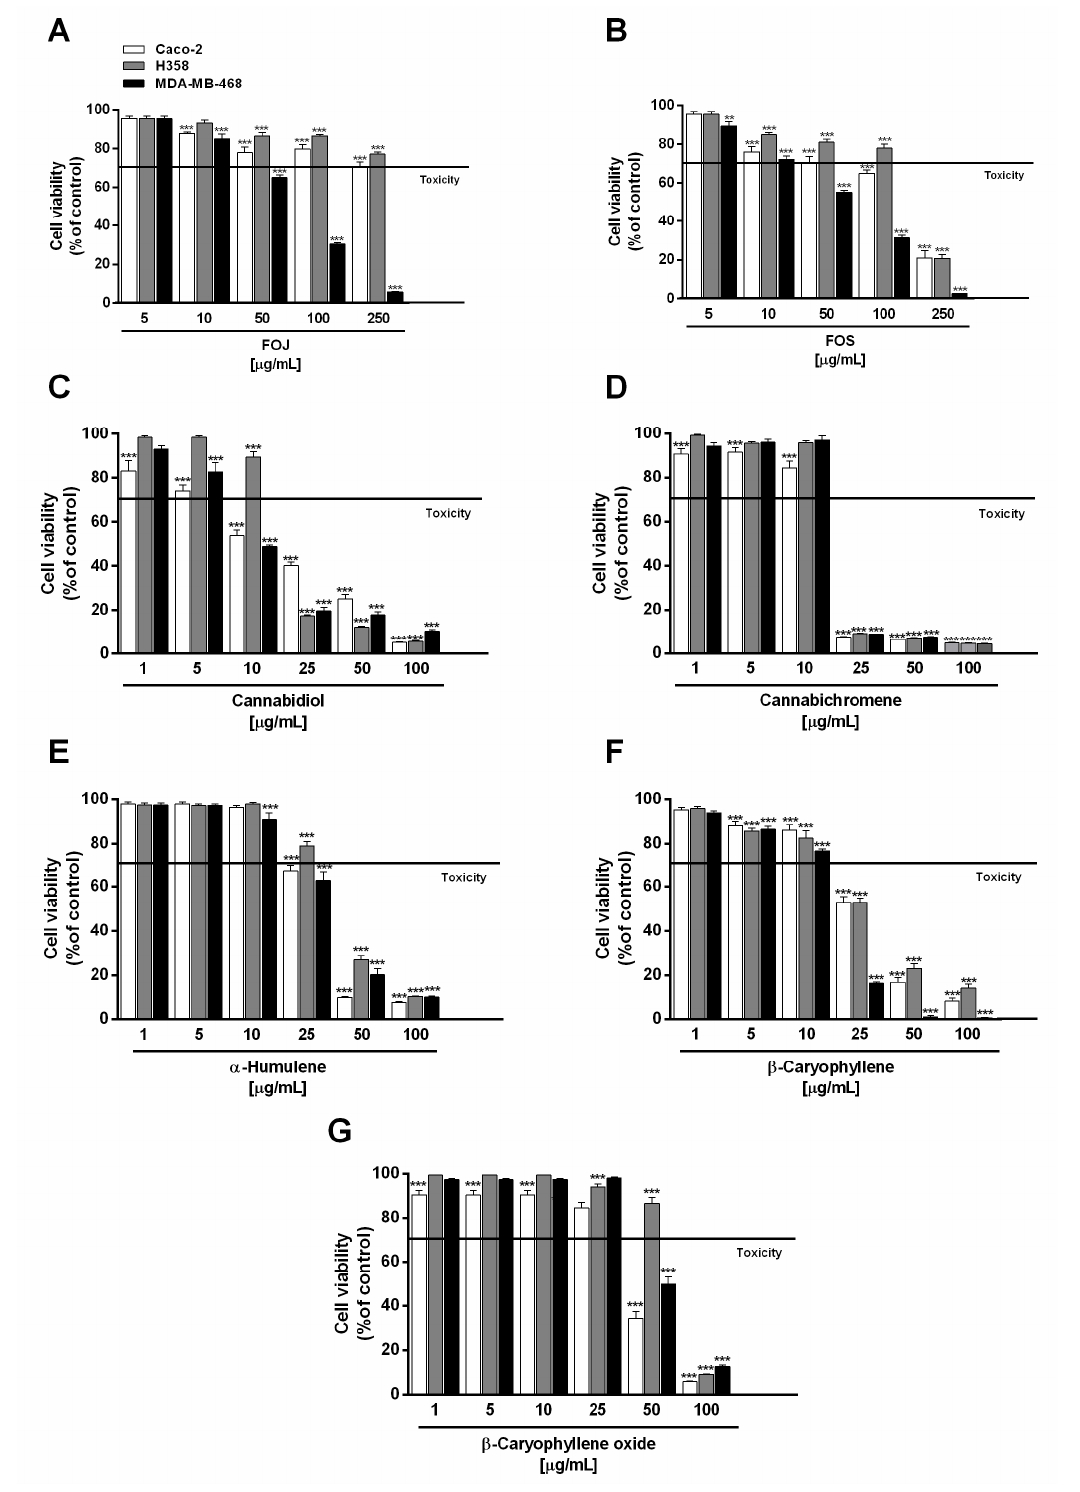
Figure 1. Cytotoxic effect of the organic extracts from the inflorescences of Cannabis sativa var. Felina 32 collected in June (FOJ) and September (FOS) ( A , B ), cannabidiol ( C ), cannabichromene ( D ), α -humulene ( E ), β -caryophyllene ( F ), and β -caryophyllene oxide ( G ) after 24 h treatment of human triple negative breast cancer (MDA-MB-468), human epithelial colorectal adenocarcinoma (Caco-2), and human bronchoalveolar carcinoma (H358) cells. Data are expressed as mean ± SEM of at least three independent experiments with three technical replicates ( n = 9); ** p < 0.01 and *** p < 0.001 vs. control determined by ANOVA followed by Dunnett’s multiple comparison post hoc test.